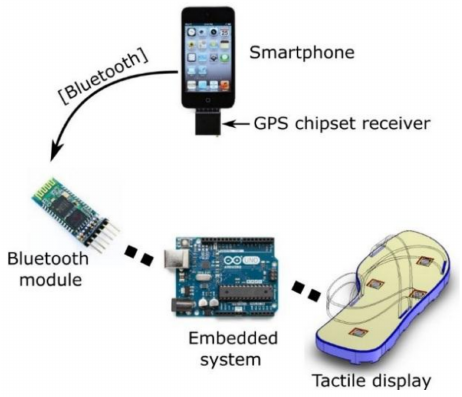
Figure 8. Proposed architecture for the assistive navigation system. The smartphone incorporates the GIS and the route planner and sends the direction commands to the tactile